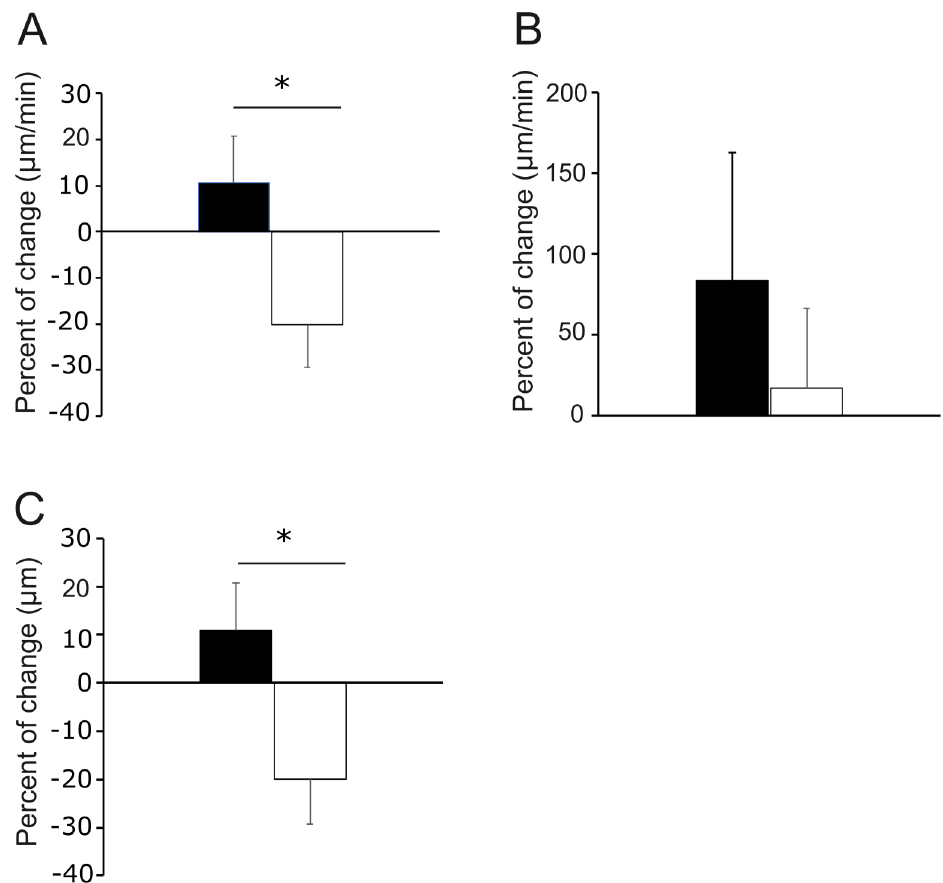
Figure 5. Percentage of change in membrane projection of PC12 active or static cells under laser irradiation. The percentage of change of ( A ) average speed, ( B ) average velocity, and ( C ) average distance was obtained from the irradiated regions of cell membranes before and after laser stimulation. Black columns correspond to cells that were projecting for at least five minutes before the beginning of laser irradiation (active); white columns correspond to cells that were immobile or retracting at the beginning of the laser irradiation (static). Bars represent the standard error. Asterisk (*) indicates statistically significant difference between the two conditions (Student’s t test p < 0.05). n = 8 cells per condition.